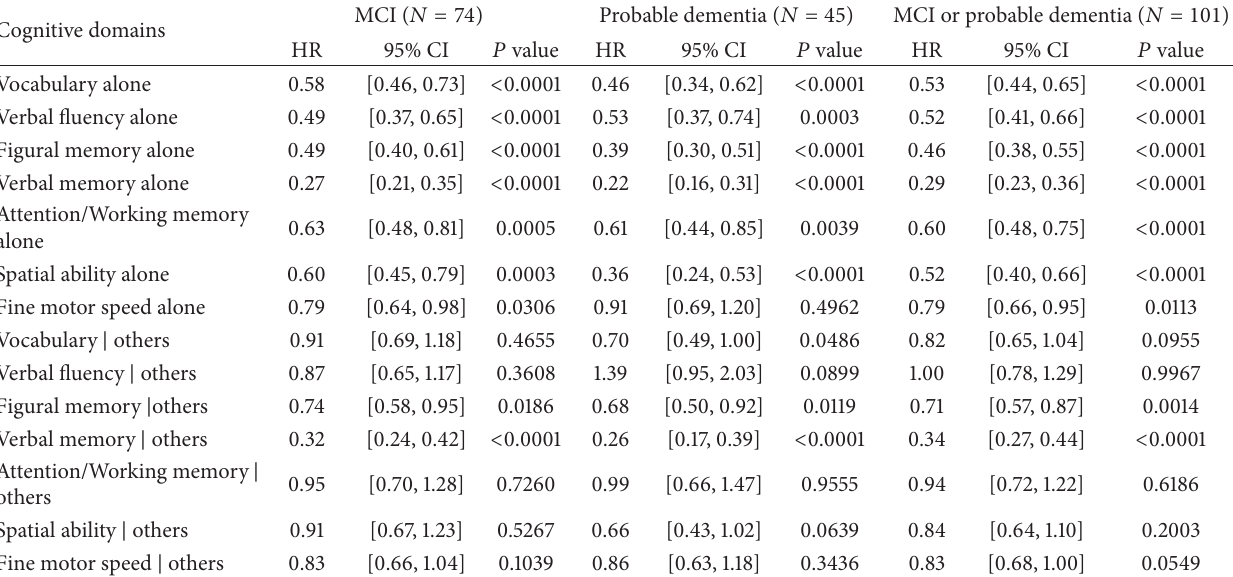
Table 2: Hazard ratios for the cognitive domains (alone and controlling for all other cognitive domains) predicting MCI, probable dementia, and MCI or probable dementia.